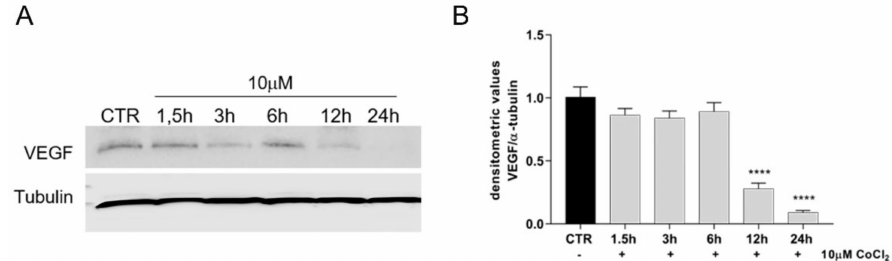
Figure 4. Analysed VEGF expression, in untreated oAECs (CTR) and 10 µ M CoCl 2 -treated oAECs. ( A ) Representative Western blot image of VEGF expression in a time course experiment conducted at 1.5 h, 3 h, 6 h, 12 h, and 24 h. ( B ) Densitometric values of VEGF were normalized on Tubulin expression. Data were expressed as mean ± SEM values of samples, each performed in triplicate, obtained at least three different animals. Values statistically different for **** p < 0.0001 vs.